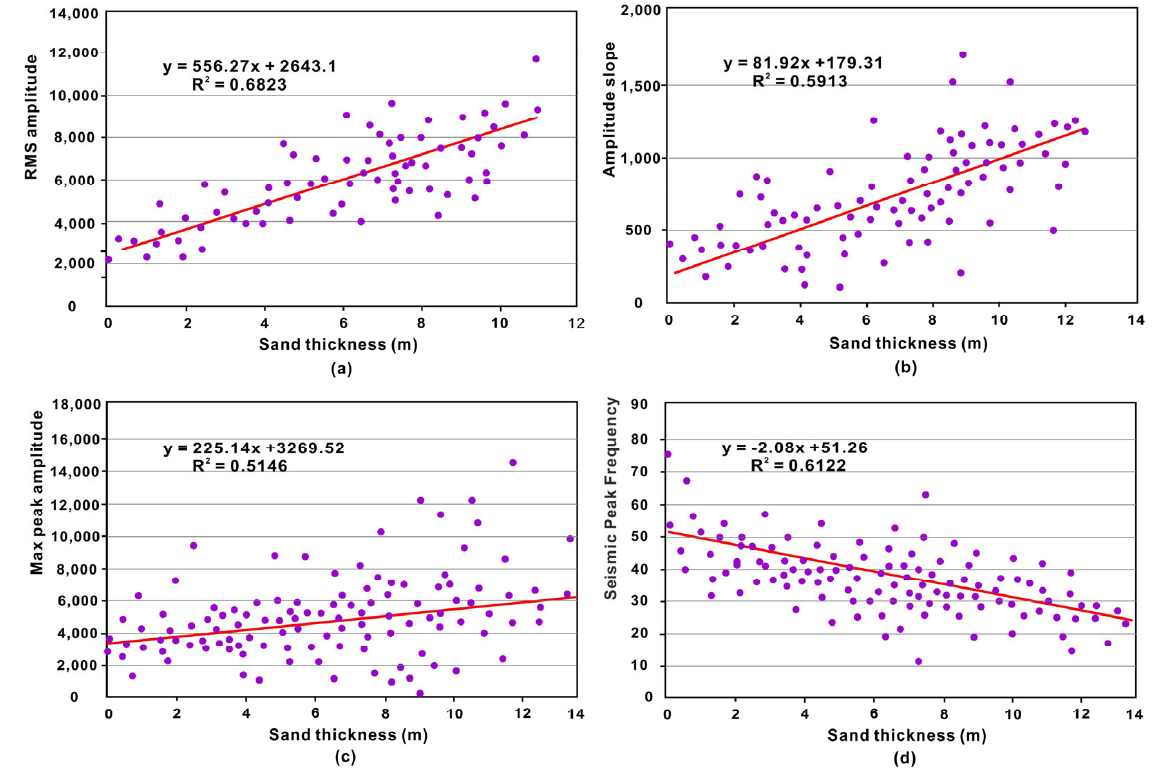
Figure 7. ( a ) Correlation between sand thickness and RMS. ( b ) Correlation between sand thickness and amplitude slope. ( c ) Correlation between sand thickness and max peak amplitude. ( d ) Correlation between sand thickness and seismic peak frequency(purple circles are data points).